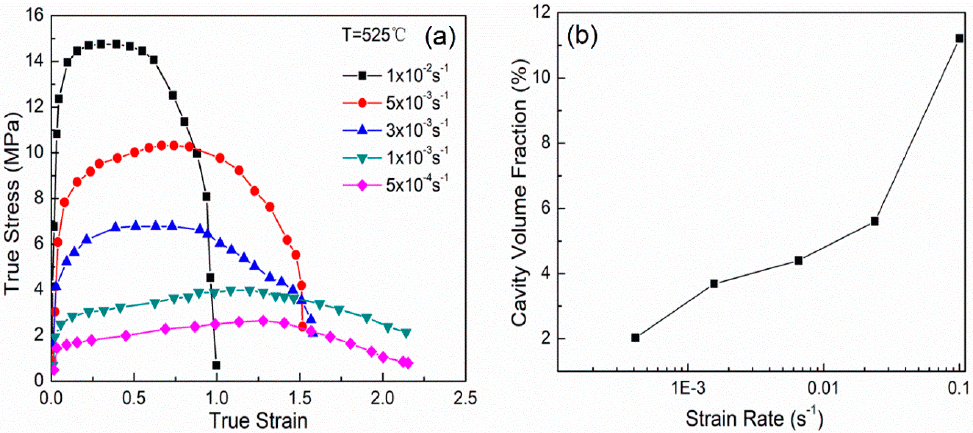
Figure 5. ( a ) Effect of strain rates on true strain-true stress curves, reproduced from [81], with permission from Elsevier, 2009. ( b ) Variation of cavity volume fraction with strain rate, reproduced from [82], with permission from Cambridge University Press, 2004.